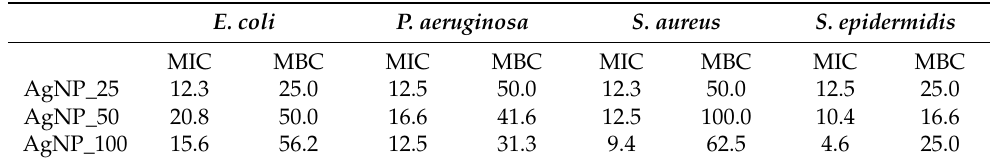
Table 3. MIC and MBC values of AgNPs solutions for E. coli, P. aeruginosa, S. epidermidis , and S. aureus expressed in